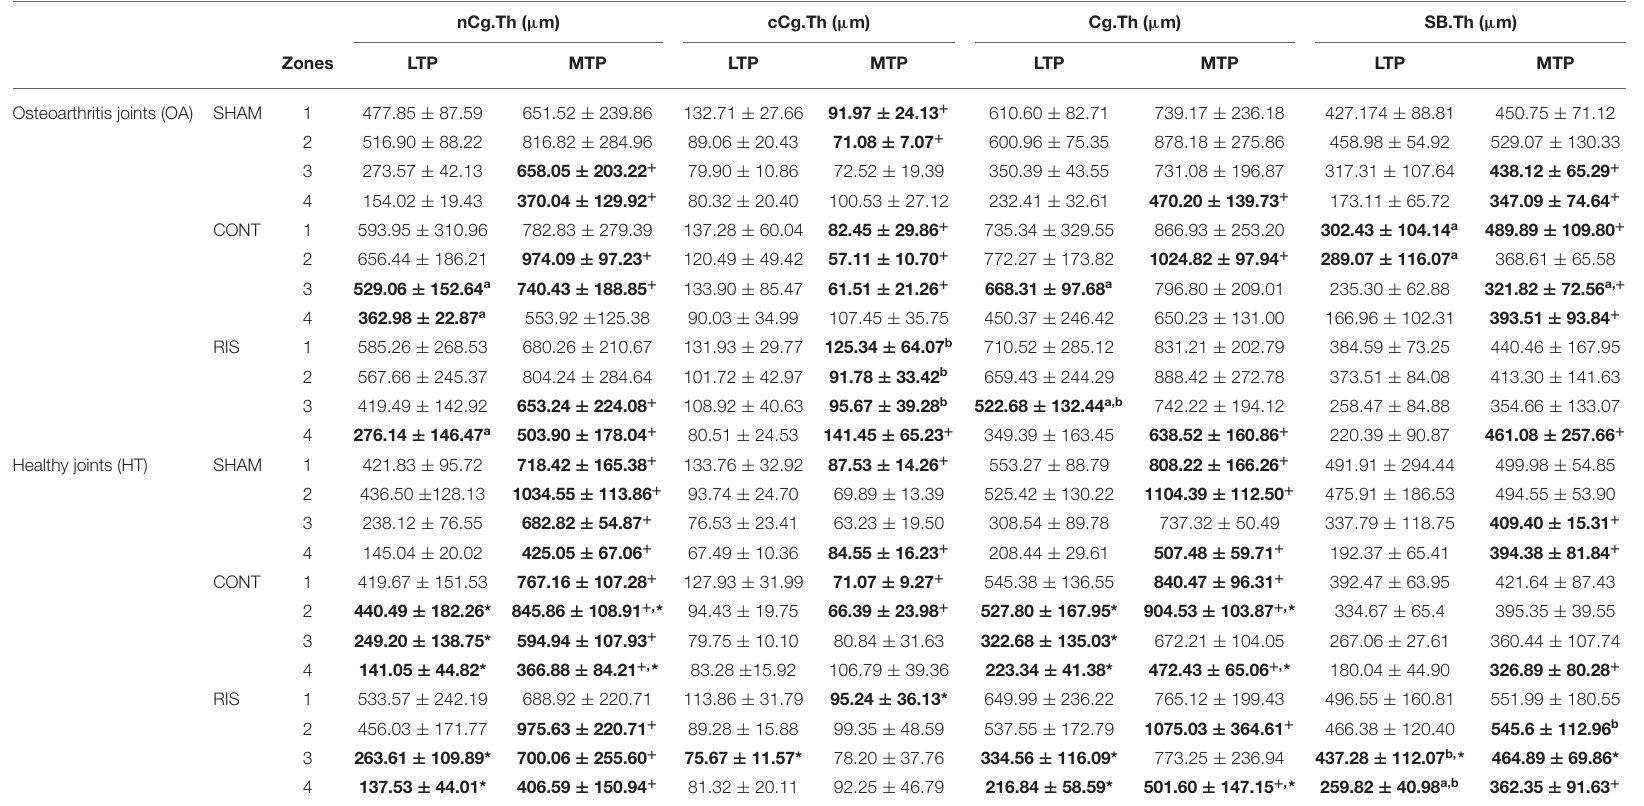
TABLE 2 | Stereologic histomorphometric analysis of tibial